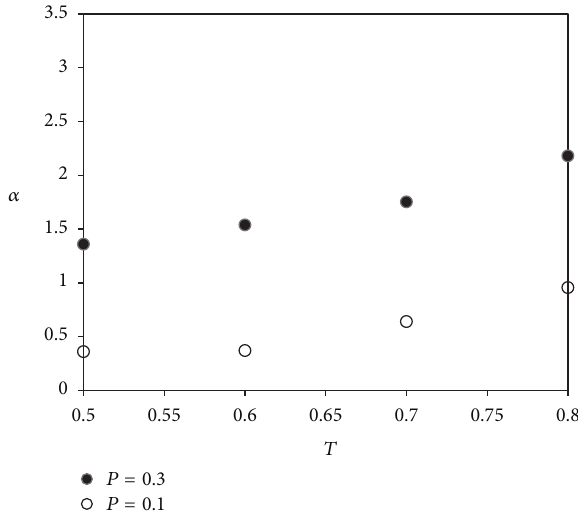
Figure 10: QLRO is characterized by a power law 𝑆(𝑇) dependence. Homogeneous history . 𝑃 = 0.2 , 𝑊 = 1 .